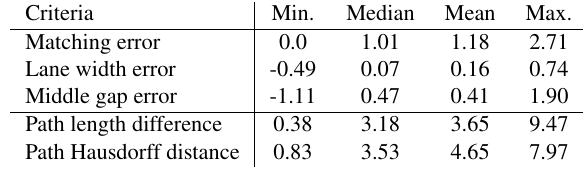
Table 2. Stage 2 (GPS, IMU, DMI) evaluation